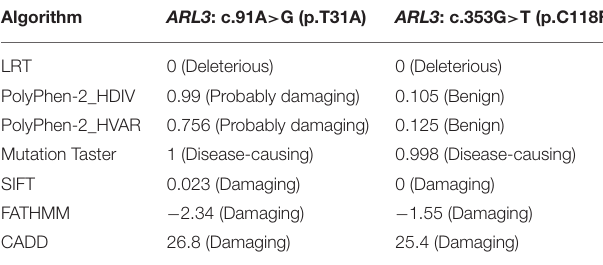
TABLE 1 | In silico pathogenicity